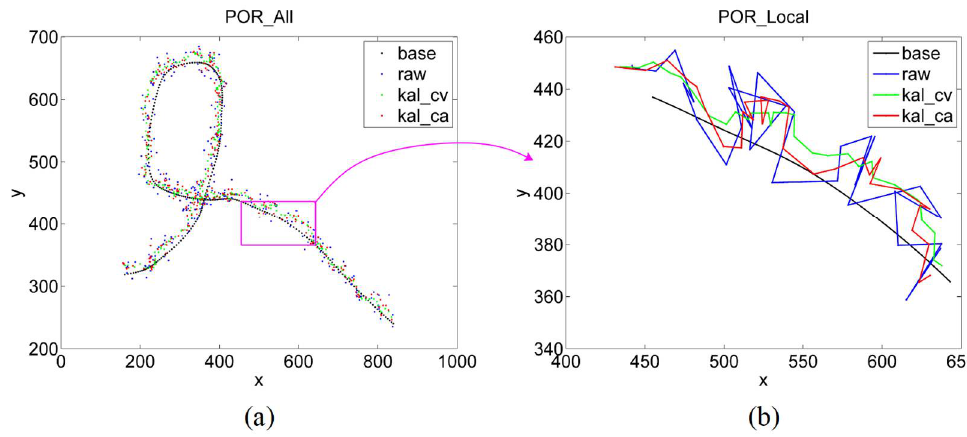
Figure 16. POR results of a randomly moving gaze point. ( a ) The all POR results. ( b ) A local POR